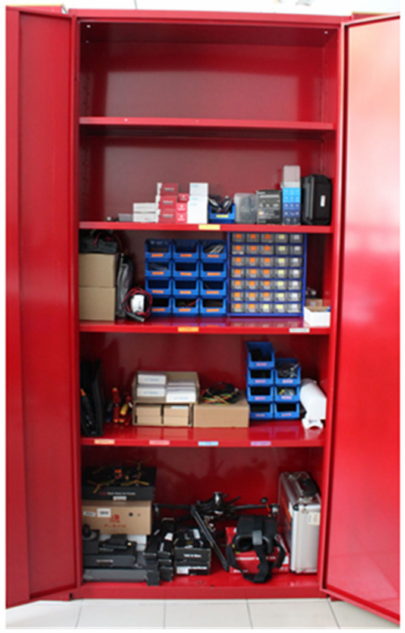
Figure 4. Cabinet after the implementation of Lean tools.